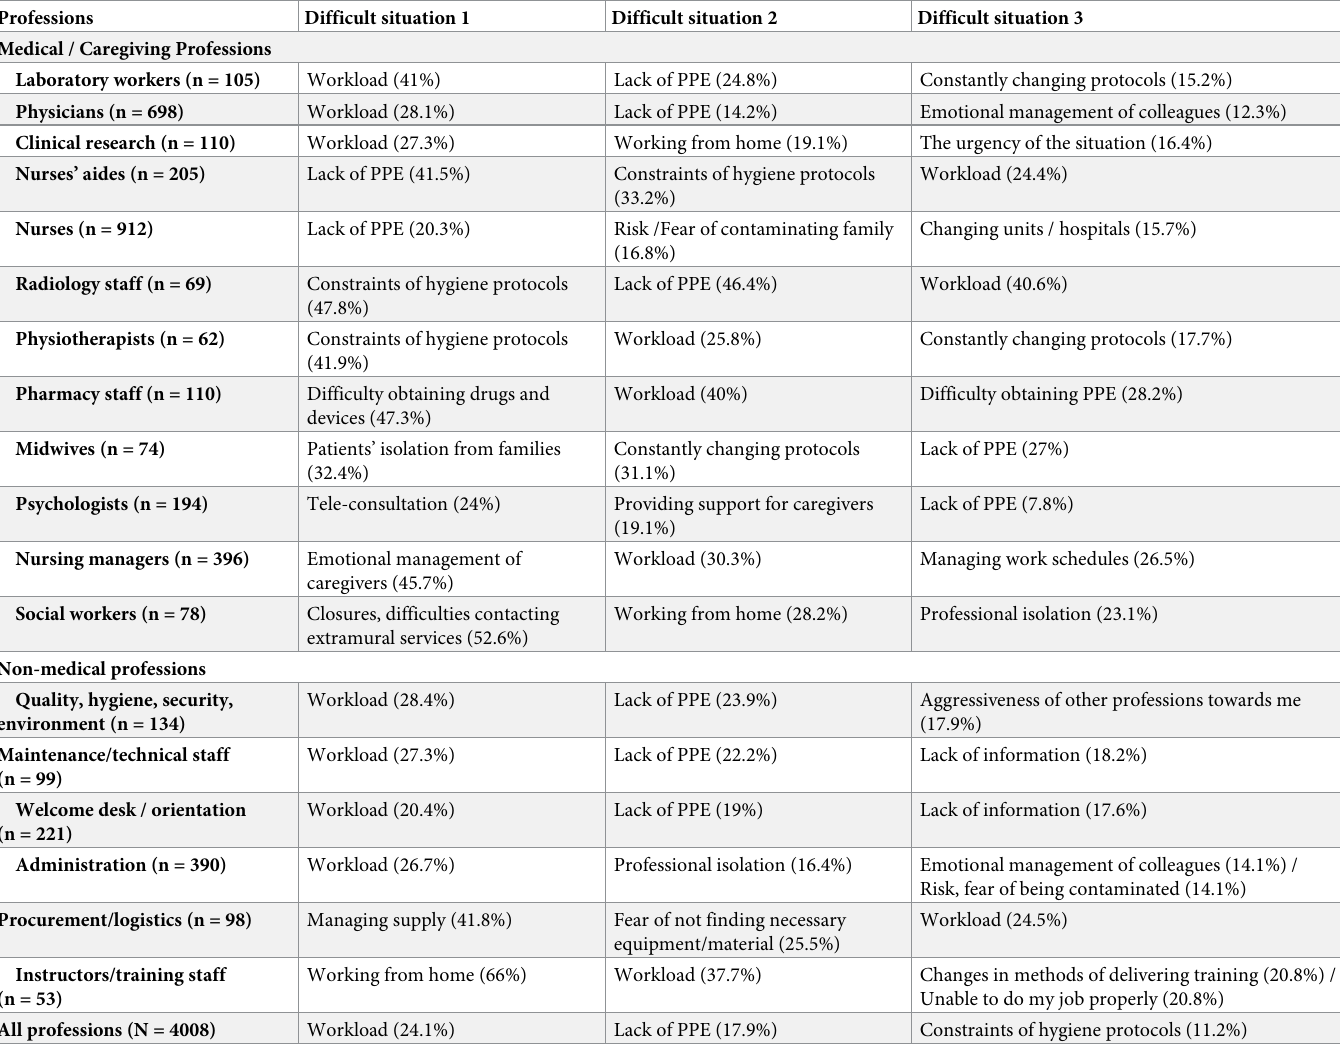
Table 2. Analysis of text answers to the open-ended questions identifying the three most frequently cited difficult situations for each professional